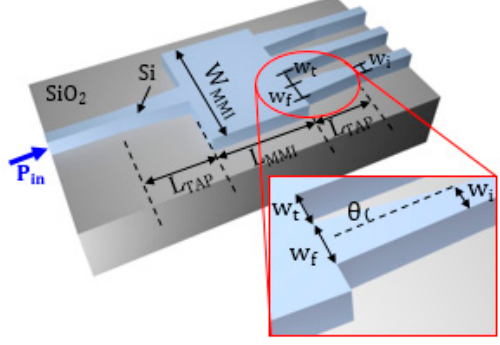
Figure 9. Configuration of the 1 × 3 SOI MMI with a focus on the tapering section in the inset.